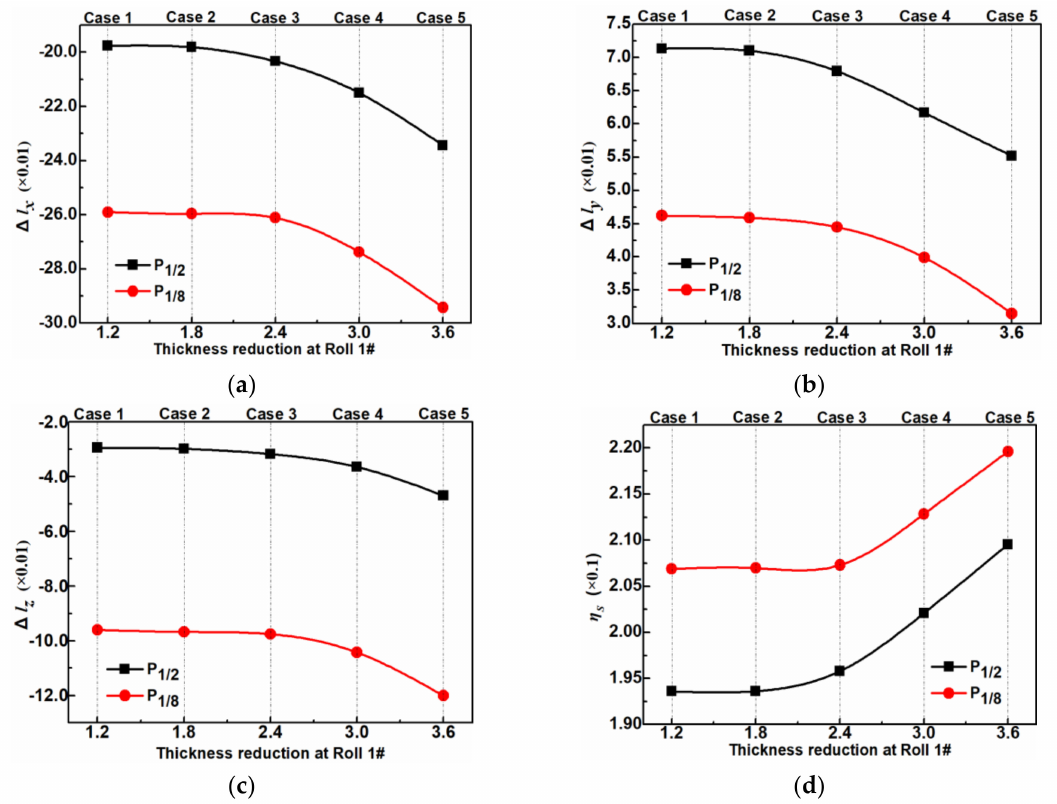
Figure 18. Porosity deformation degree along the ( a ) slab thickness direction, ( b ) casting direction, ( c ) slab width direction, and ( d ) the porosity closure degree after 6% HR deformation in Case 1 to 5.